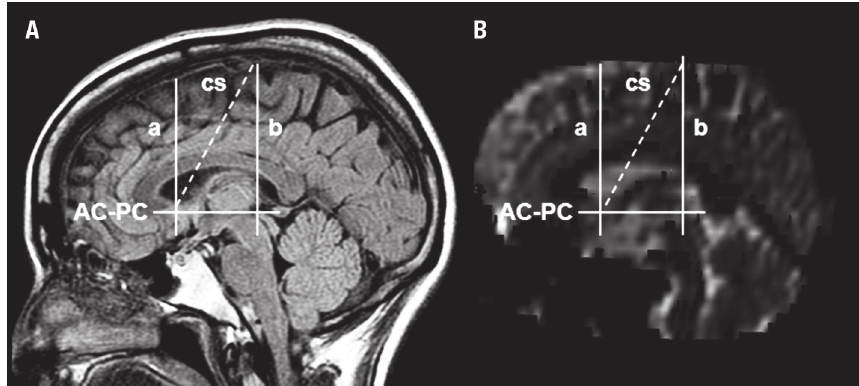
Figure 1. Main markers used to limit prefrontal region. [A] MR sagittal plane and T1 acquisition. [B] Reconstructed sagittal plane from EPI (echo-planar imaging). The prefrontal region is anterior to the anterior commissure plane, and the premotor-motor region is anterior to the central sulcus line (broken line) 52-54 . AC-PC: anterior commissure-posterior commissure line; a: anterior commissure plane; b: posterior commissure plane; cs: central sulcus line (broken line).